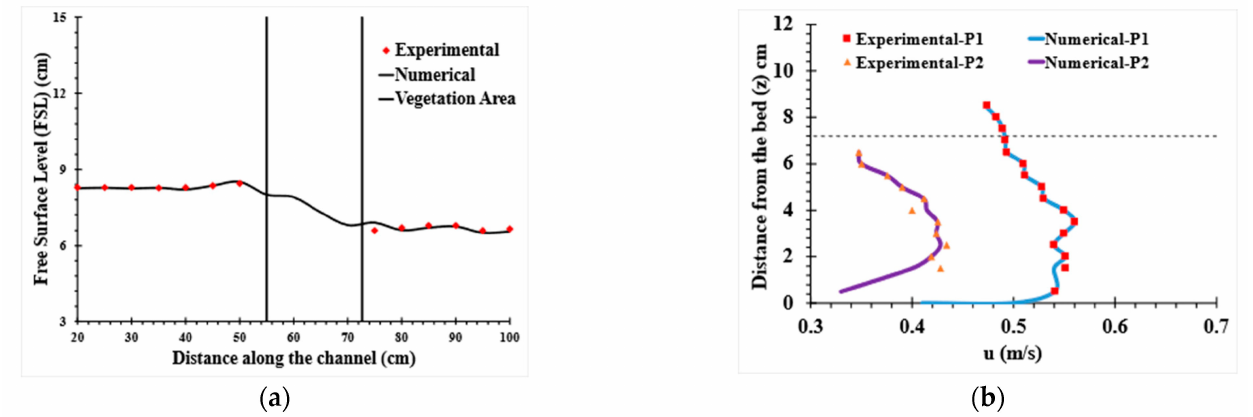
Figure 6. ( a ) Comparison of computed and experimental free surface level (FSL) profiles: ( b ) Com- parison of computed and experimental vertical distribution of streamwise